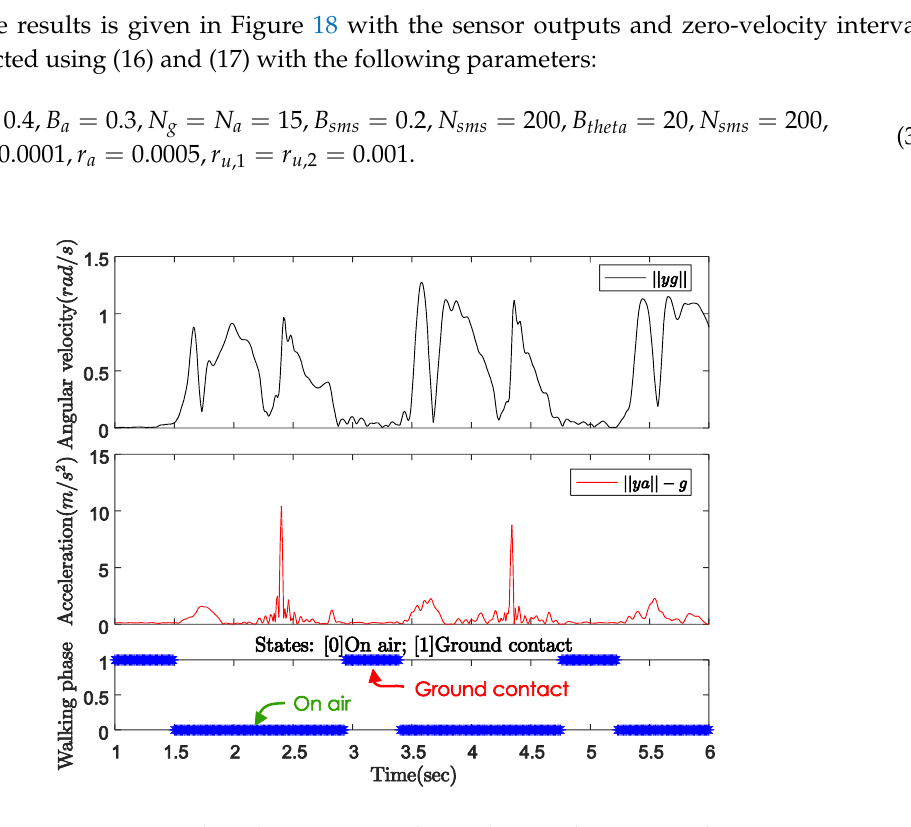
Figure 17. Continuous walking within the working range of an optical tracker system.